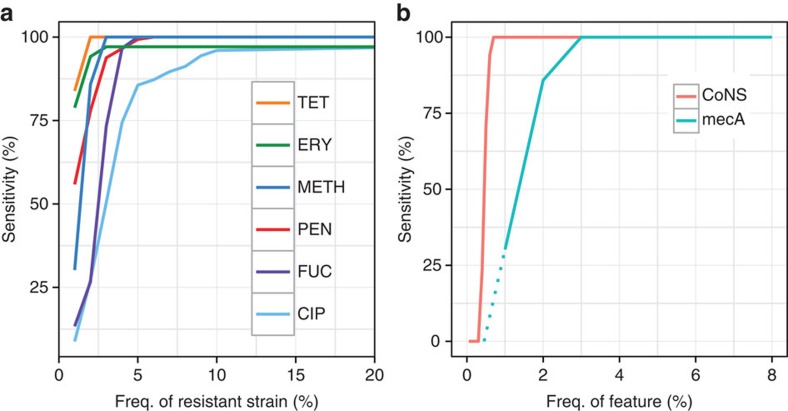
Power to detect minor populations.(a) Simulation 2: power to detect minor resistant alleles in 27,000 in silico mixtures created by taking 1,000 pairs of S. aureus samples and mixing each pair in 27 different ratios. As above, we do not estimate false-negative rates for drugs where we have <10 resistant samples, as confidence intervals would be unreasonably large. Power is greatest for the drugs where resistance genes reside on multi-copy plasmids, namely erythromycin and tetracycline. Tet, tetracycline; Ery, erythromycin; Meth, methicillin; Pen, penicillin; Fuc, fusidic acid; Cip, ciprofloxacin. (b) Power to detect low-frequency coagulase-negative species (red, simulation 1, N=540, described above) is consistently higher than power to detect mecA (blue, simulation 2, N=27,000, frequencies down to 1% only due to large sample numbers; dotted lines extrapolate linearly from points at 1 and 2%), which causes methicillin resistance in S. aureus. Thus, the risk of detecting mecA but not detecting the coagulase-negative species it comes from is limited.